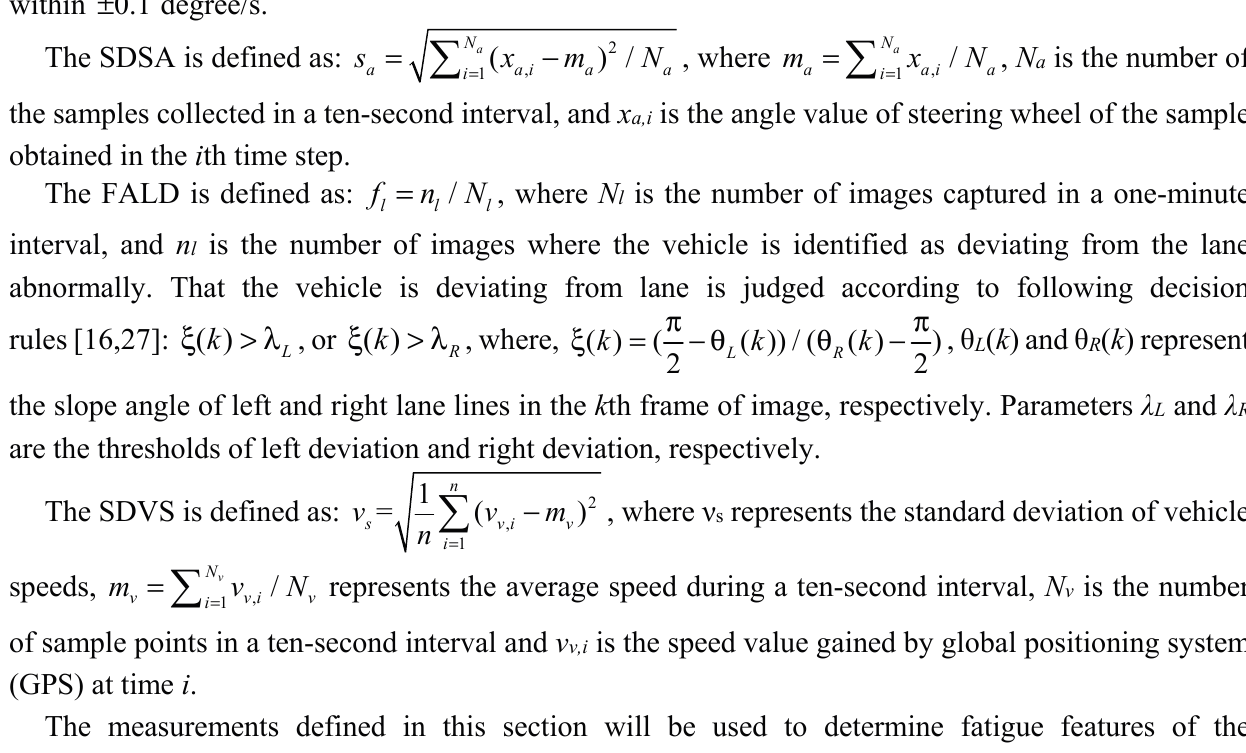
Figure 1. The key components and recognition procedures of the fatigue driving recognition model are as